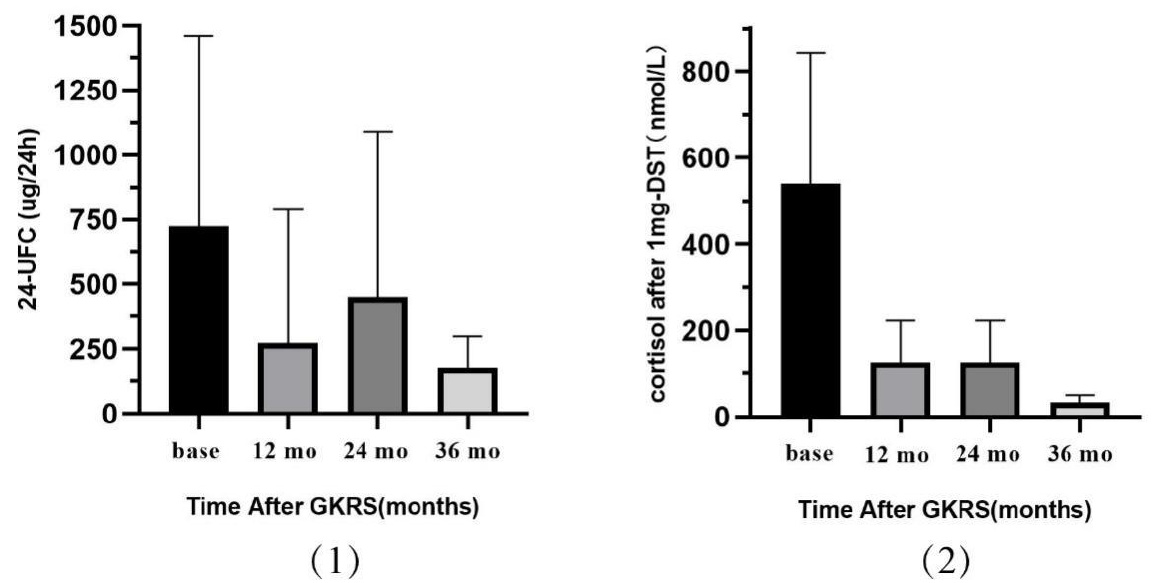
Figure 1. The trend of the 24 UFC ( 1 ) and cortisol after 1 mg DST ( 2 ) for patients with Cushing’s disease after receiving GKRS.